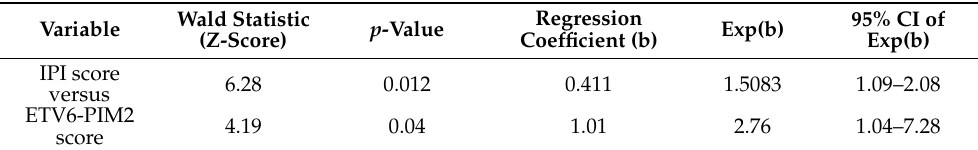
Table 4. Multivariate survival analysis of the ETV6-PIM2 protein score with OS as dependent variable in our cohort of DLBCL